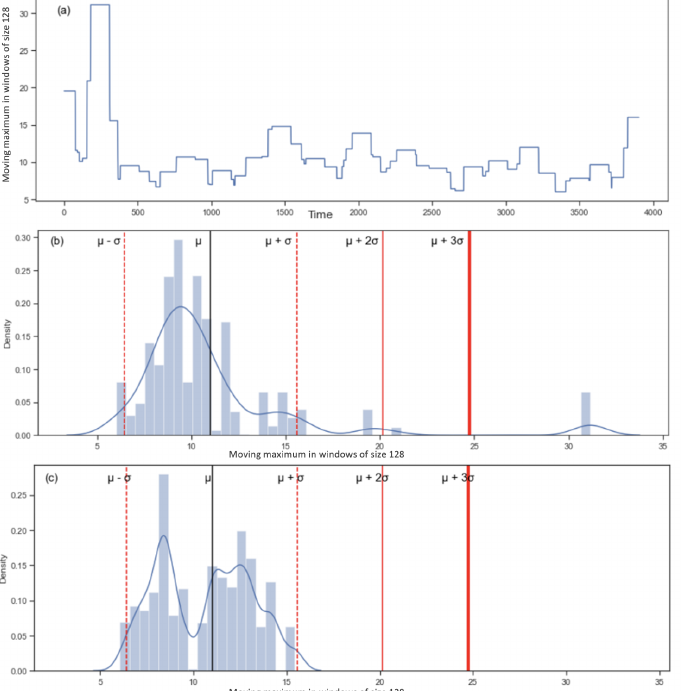
Figure 11. The upper panel ( a ) represents an example of the moving maximum for each window of 128 values for the breathing signal. The middle panel ( b ) represents the training distribution of the values in ( a ). The values between the two red lines µ − σ and µ + σ (around 5 and 15) represent normal breathing. The values that are on the left of µ − σ (0 to around 5) represent shallow breathing and the values that are located at µ + σ and more represent deeper breathing. The lower panel ( c ) represents the testing distribution compared to the threshold defined in panel ( b